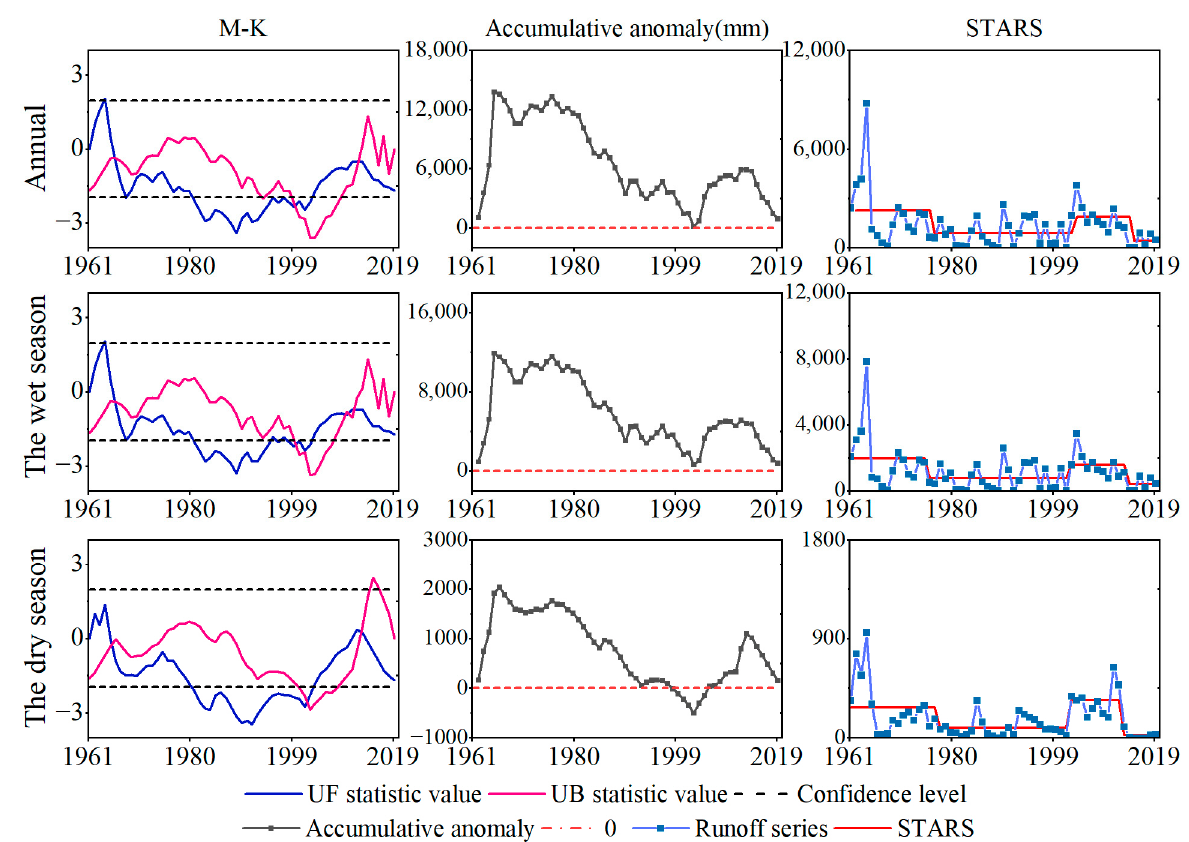
Figure 8. The mutation analysis of the runoff at Dawenkou station.